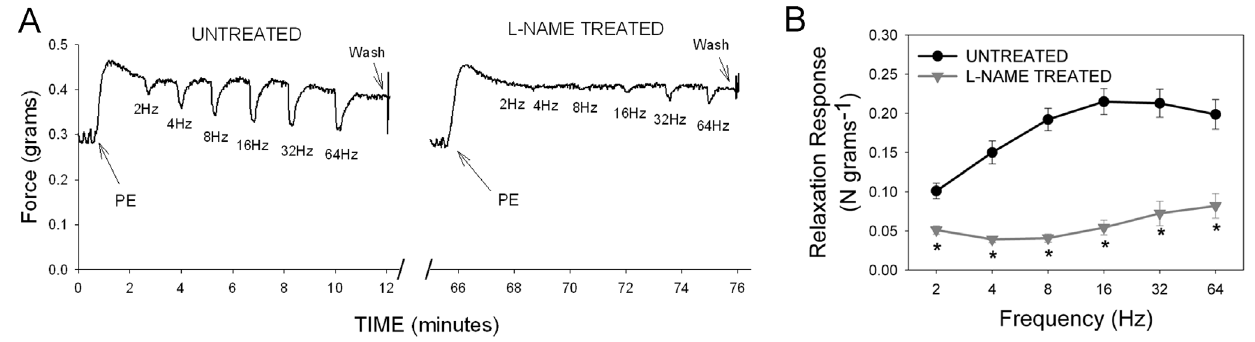
Figure 5. Effect of L-NAME on nerve-mediated relaxation in mouse corpora cavernosa of penis. (A) Representative tracing showing pre- contraction induced by phenylephrine (PE, arrows) and relaxation to increasing frequencies of stimulation in a WT mouse before (baseline) and after L-NAME treatment. Note the relaxation responses increased in amplitude with increasing stimulus frequencies. (C) In graph, frequency-relaxation responses under baseline conditions (black circles) were significantly attenuated by L-NAME (gray triangles) in WT mice. [n=5; *significantly lower than baseline; p=0.00002, paired t-test].